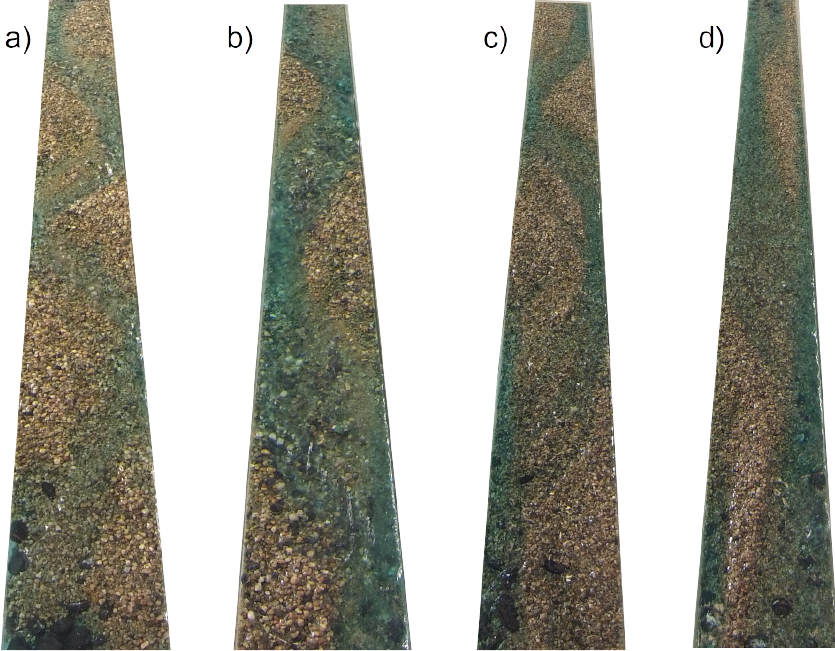
Figure 9. Example images of bed state taken from GSD broad at low (a) and high (b) discharge, and GSD narrow at low (c) and high (d)